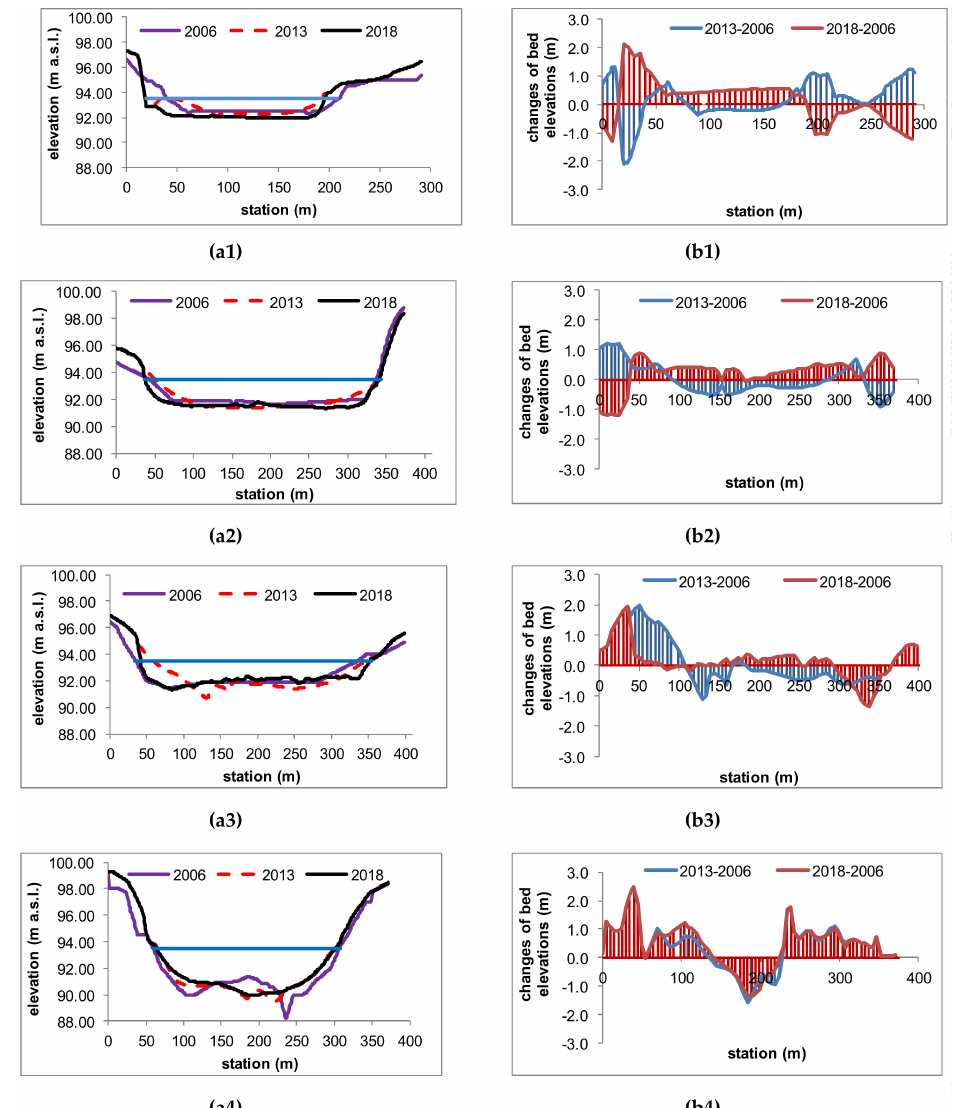
Figure 10. Selected cross-sections: ( a ) Bottom and water surface elevations for three bathymetries; ( b ) difference in bottom elevations between 2006 and 2013, as well as between 2006 and